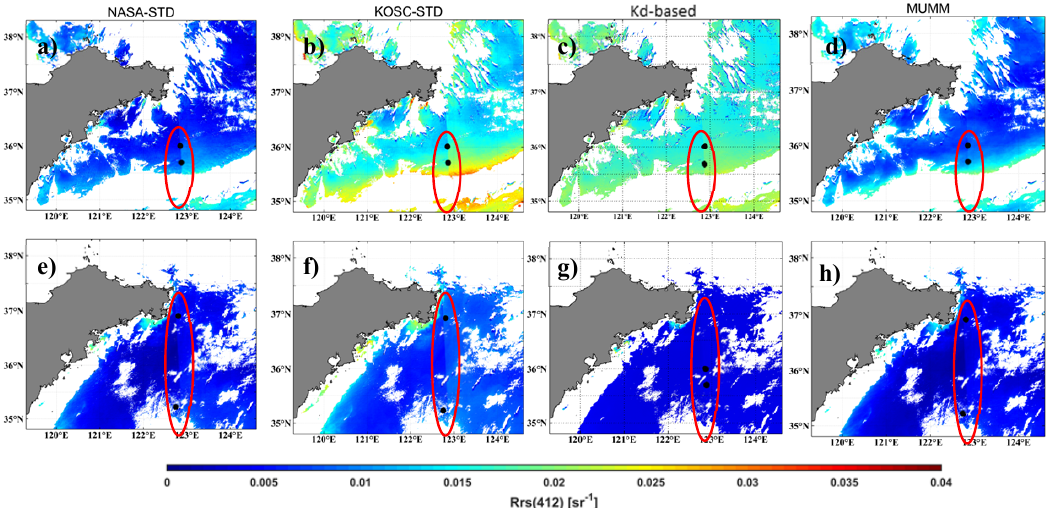
Figure 10. Red ellipses highlight slot border effects. The black dots denote the match-ups located in the slot border. Each column (left to right) represents Rrs(412) for NASA-STD, KOSC-STD, Kd-based, and MUMM algorithms, respectively. ( a – d ) and ( e – h ) depict results for 22 and 23 August 2017 (UTC = 03:00), respectively.